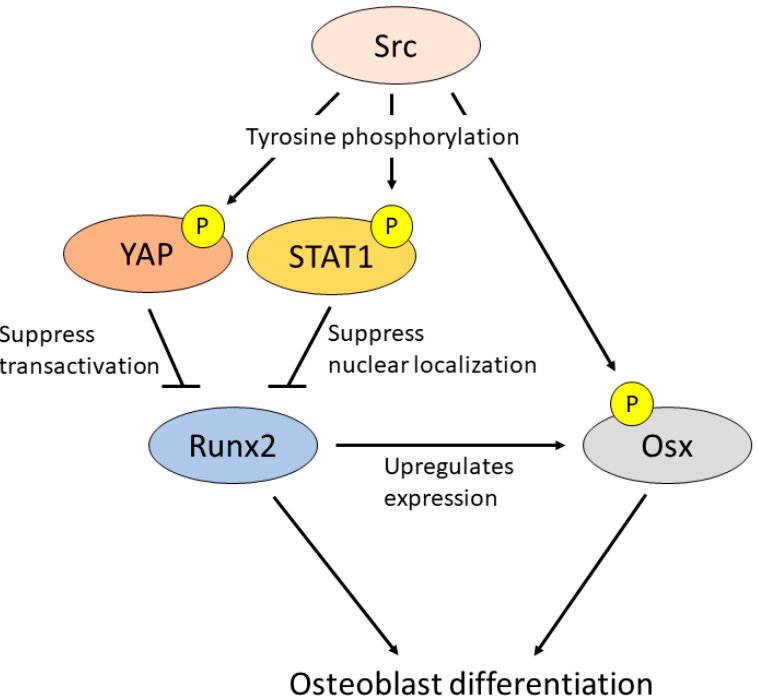
Figure 3. Schema of Src function in osteoblasts. Src activates YAP [69,70] and STAT1 [72] to suppress Runx2 transcription and osteoblast differentiation. In contrast, Src directly binds to and phosphory- lates Osx Tyr 64 and induces Osx localization in nuclear to activate transcription to promote osteoblast differentiation [74]. P; phosphor-tyrosine.